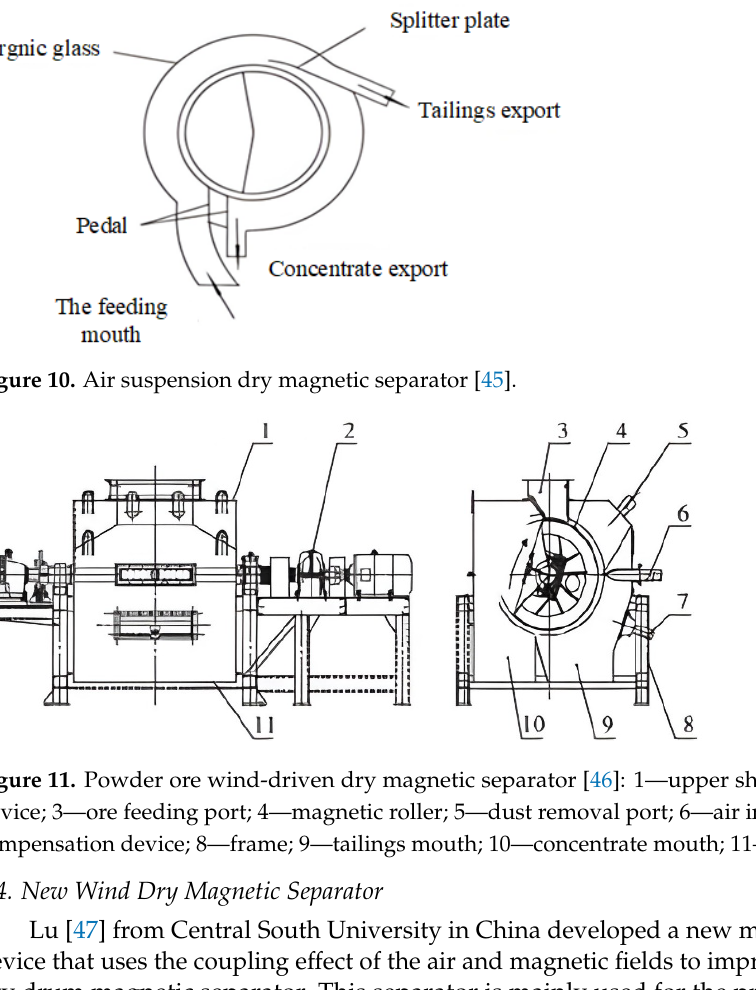
Figure 10. Air suspension dry magnetic separator [45].